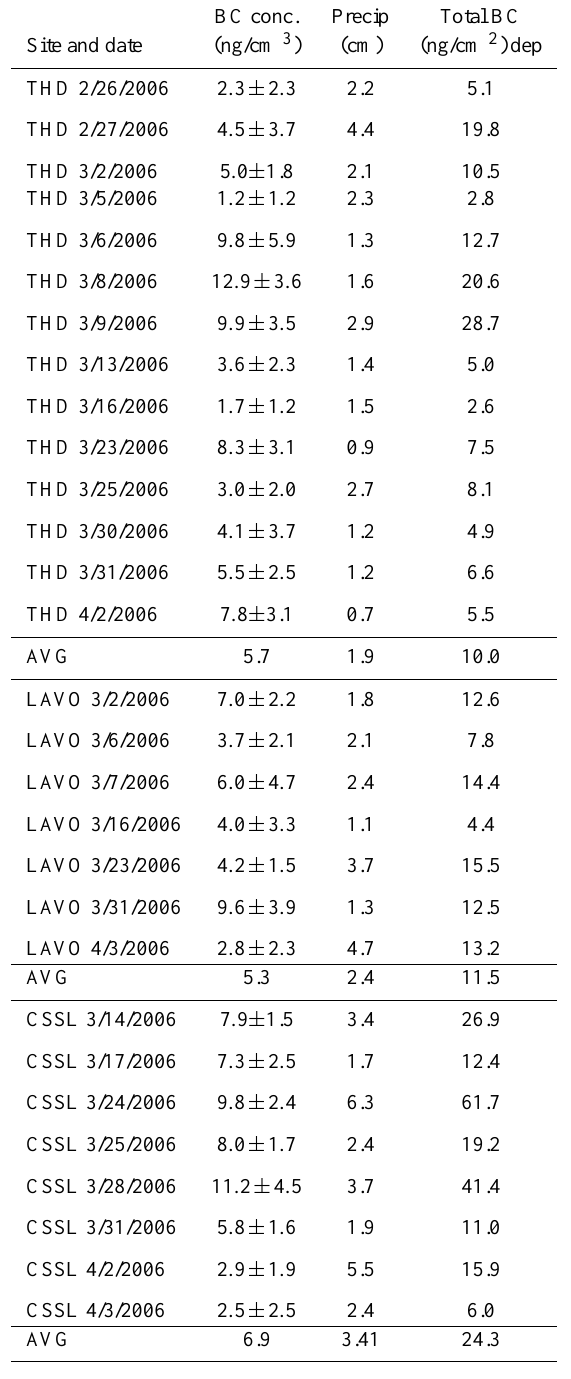
Table 1. Black carbon mass concentration measured in falling snow, precipitation amount, and total BC mass removed to the snow pack by precipitation events at Trinidad Head (THD), Lassen Vol- cano National Park (LAVO), and Central Sierra Snow Lab (CSSL). BC